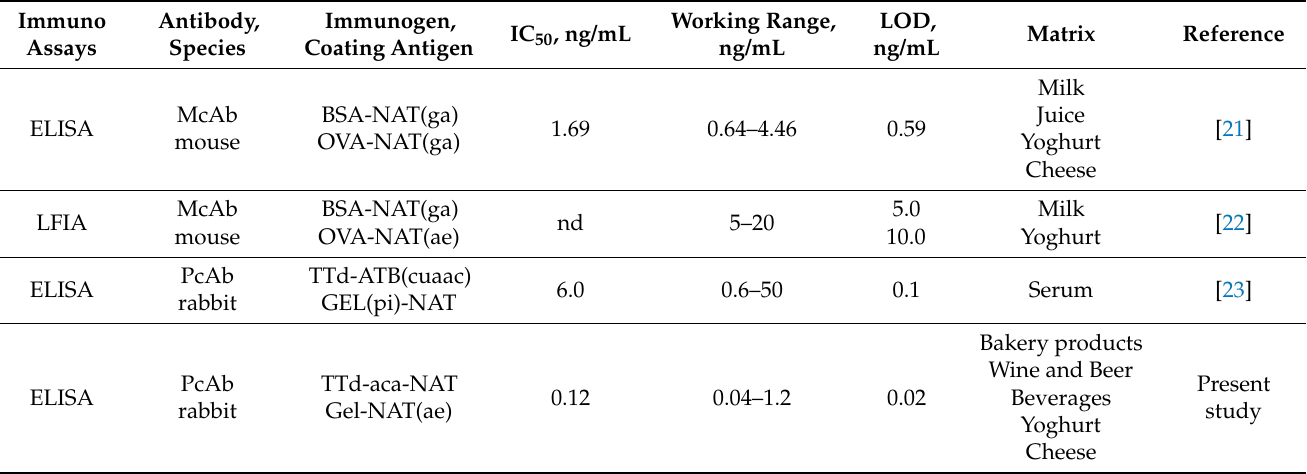
Table 2. Analytical parameters of NAT determination in the developed immunoassays.